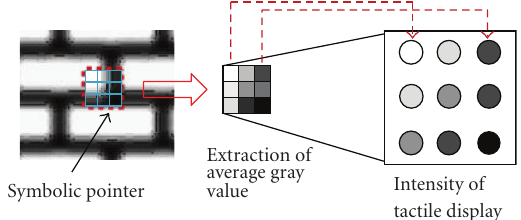
Figure 10: Methodology of pattern display.